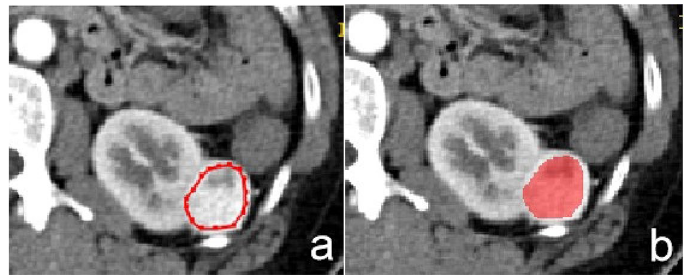
Figure 5. Manual defined smooth curve ROI was delineated, given 2–3 mm distance from the tumor